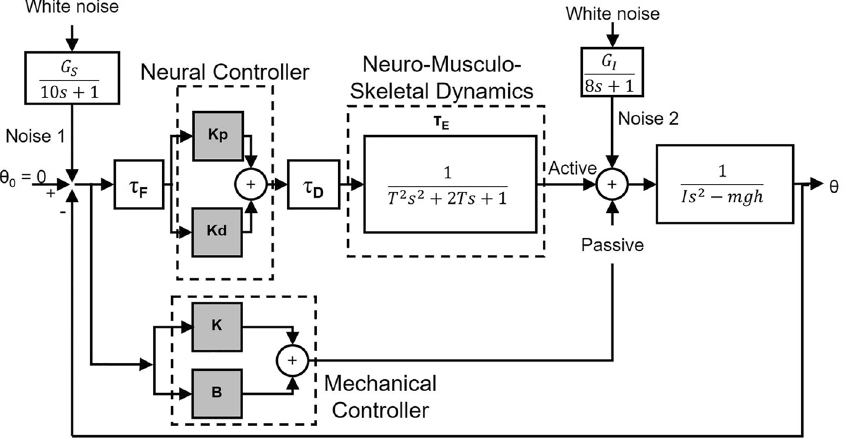
Figure 1. Computational model used for simulating the control system of quiet standing. The model consisted of a neural controller using a proportional-derivation (PD) controller with gains Kp , and Kd, and a mechanical controller using a PD controller with gains K and B . A feedback time delay (τ F = 40 ms) and motor command time delay (τ D = 40 ms) were placed within the neural controller 47,48 . After this delay, a critically damped, 2nd order model of the neuromuscular system was inserted to account for the ankle torque generation process producing the neural torque component. An inverted pendulum was used as the model of the standing body. Two first order filtered white noise inputs (G S and G I ) corresponding to the sensory and neuro-mechanical noise were injected into the system to drive the